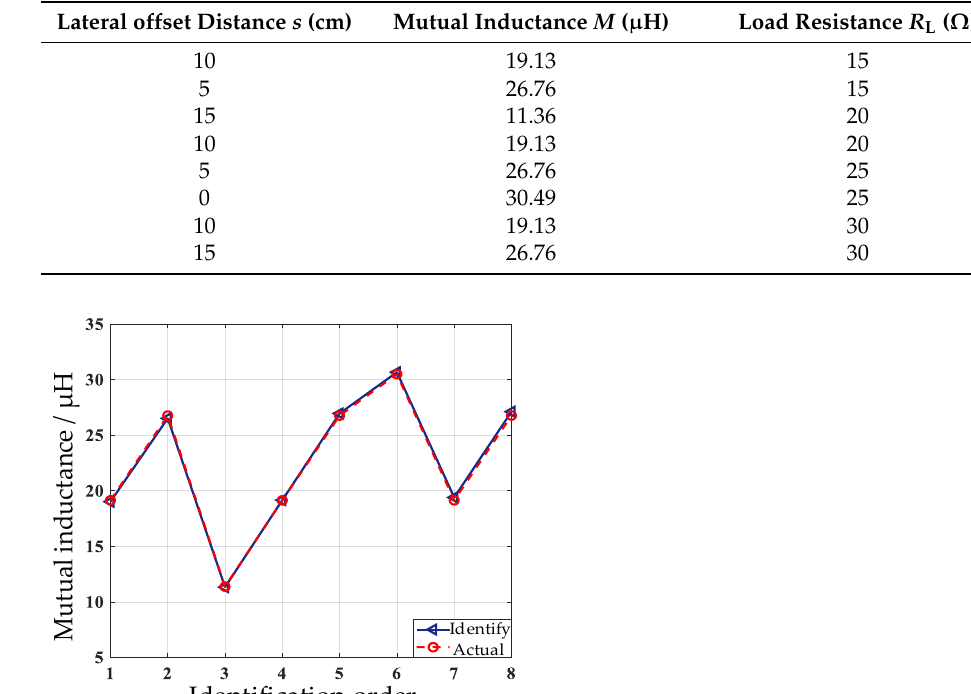
Table 3. Load resistance identified under different mutual inductance.